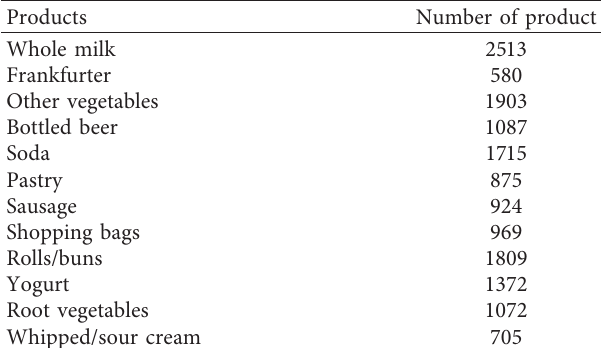
Table 13: Number of products in the Groceries dataset.